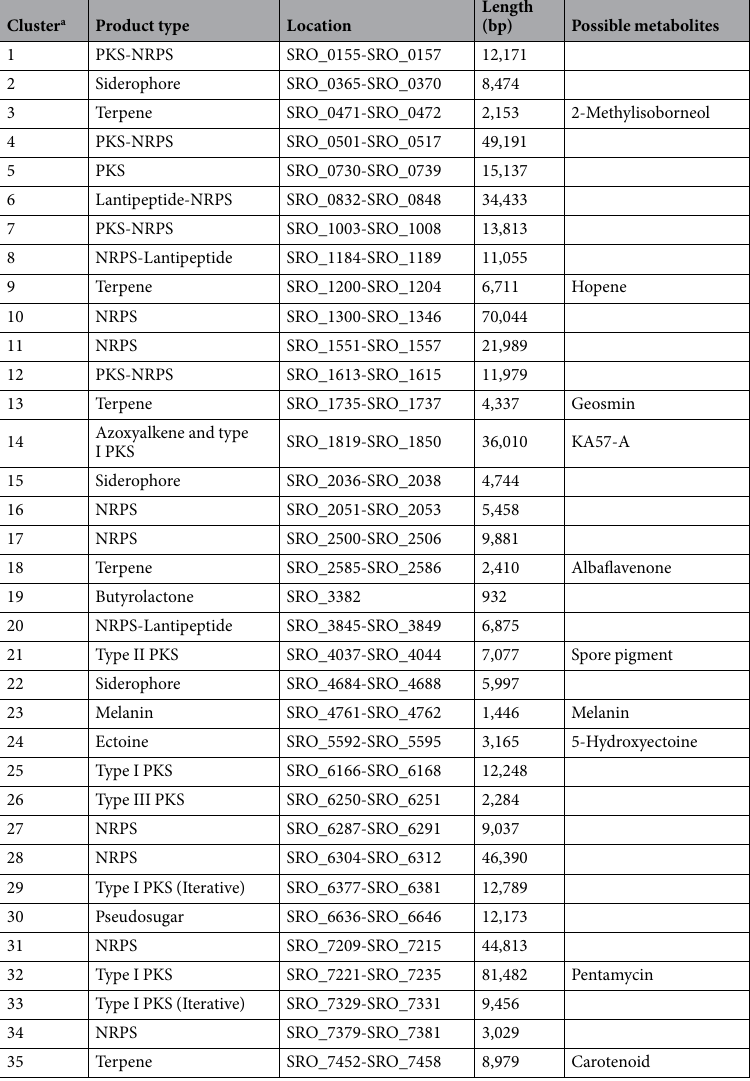
Table 3. List of secondary metabolite biosynthetic gene clusters in the S. rochei chromosome. a Secondary metabolite gene clusters were predicted by 2 nd Find and antiSMASH. The range of gene clusters for unknown secondary metabolites was estimated on the basis of putative functions of gene